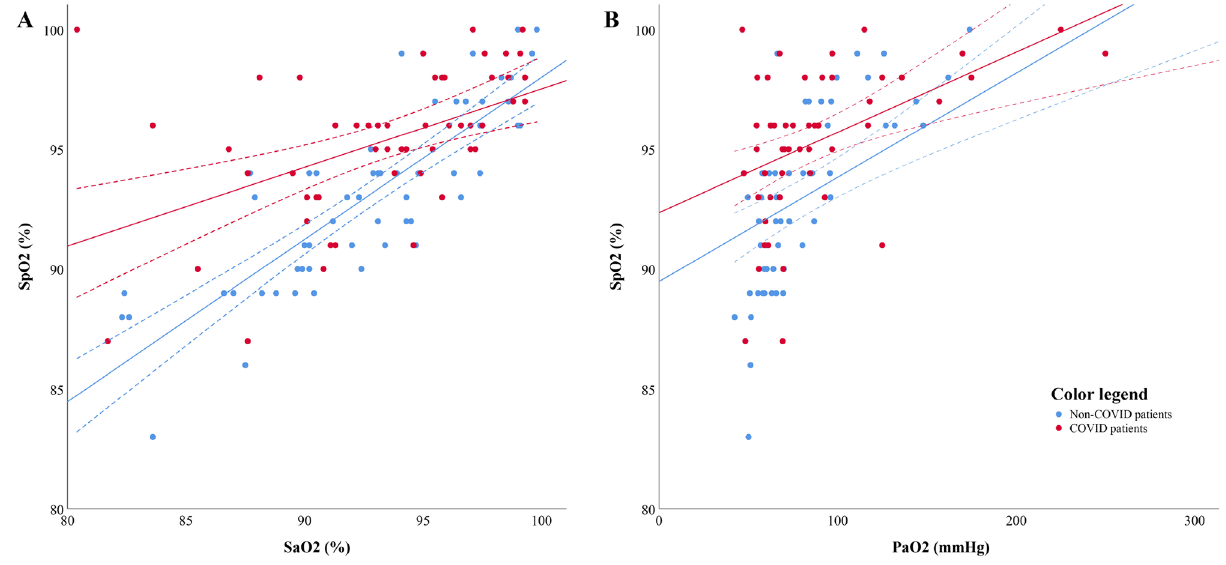
Figure 1. Panel A : correlation between pulse oximetry (SpO 2 ) and arterial oxygen saturation (SaO 2 ) in COVID- 19 patients (red points, n = 52 measurements) and non-COVID-19 patients (blue points, n = 58 measurements). The solid line represents the correlation line. The dotted lines represent the 95% confidence interval of each correlation. Panel B : correlation between pulse oximetry (SpO 2 ) and arterial oxygen partial pressure (PaO 2 ) in COVID-19 patients (red points, n = 52 measurements) and non-COVID-19 patients (blue points, n = 58 measurements). The dotted lines represent the 95% confidence interval of each